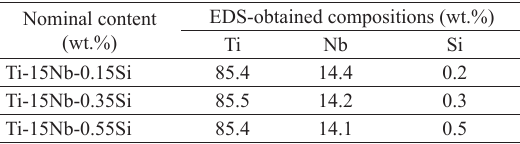
Table 2. Compositions of furnace-cooled Ti-15Nb-xSi samples based on EDS. Nominal content (wt.%)